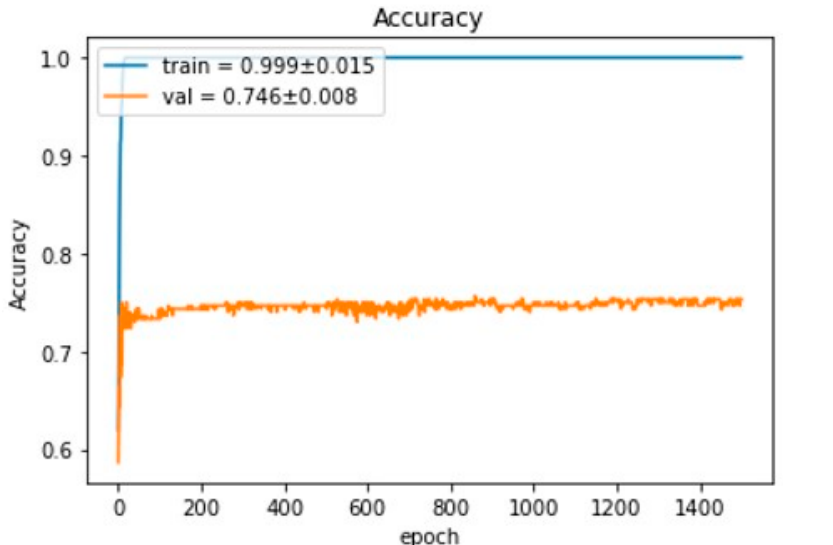
Figure 4. The confusion matrix of the validation group.